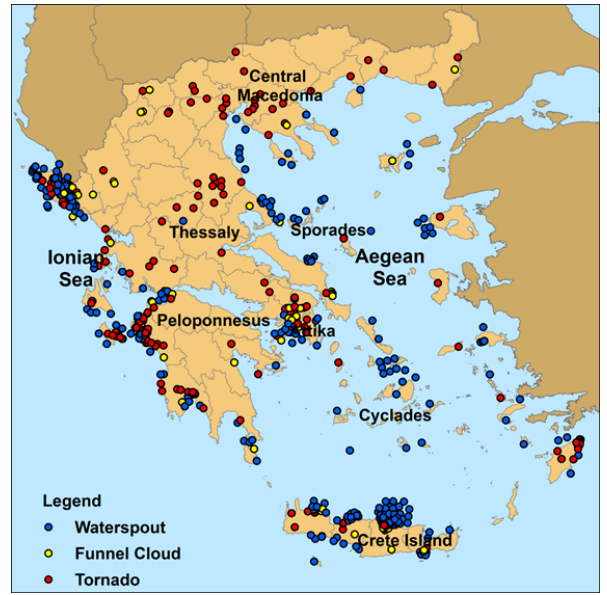
Figure 5. Spatial variability of tornadoes, waterspouts and funnel clouds over Greece for the period 1709–2012. Numerous tornadic events lie under the tornadic type symbols due to low resolution of the image (adapted from Matsangouras et al.,